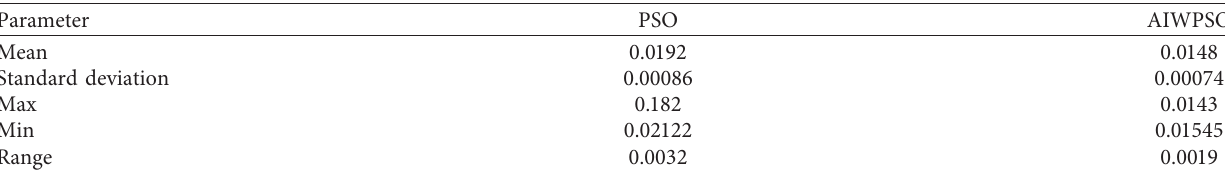
Table 3: Statistical analysis.